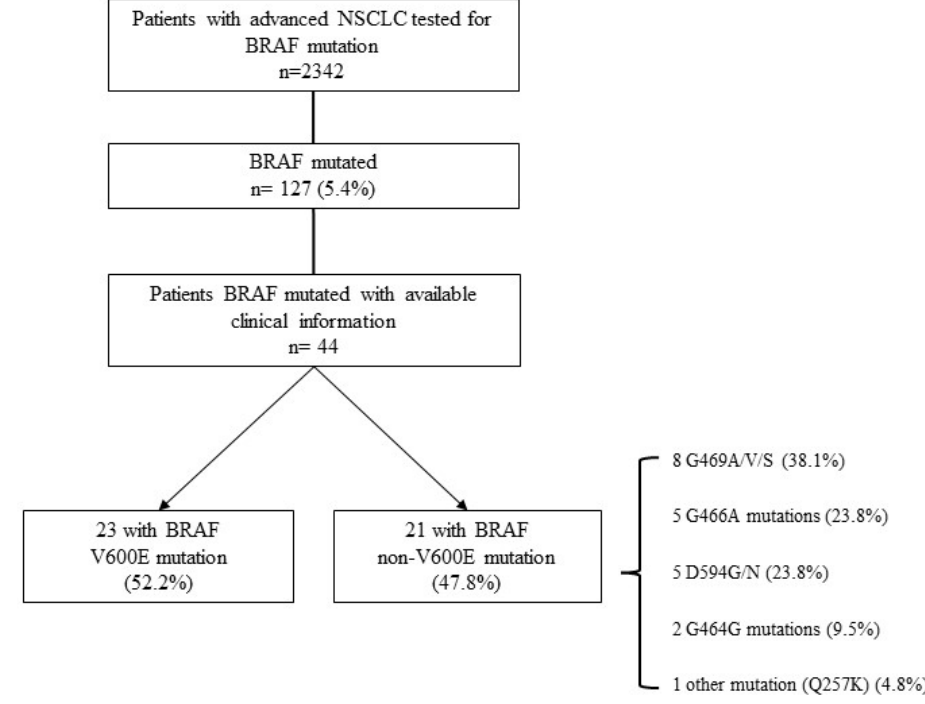
Figure 1. Consort diagram of DETECTION_KB study population: Advanced NSCLC patients included in this analysis, from 1 January 2016 to 28 February 2020. At data cut-off, 44 NSCLC cases with available clinical data and adequate follow-up were included, of which 23 presented BRAF V600E mutation (V600E group, 52.2%) and 21 (47.8%) displayed BRAF mutations other than V600E (non-V600E). Out of 21 non-V600E NSCLC, a considerable proportion (38.1%, n = 8) harbored G469A/V/S mutations